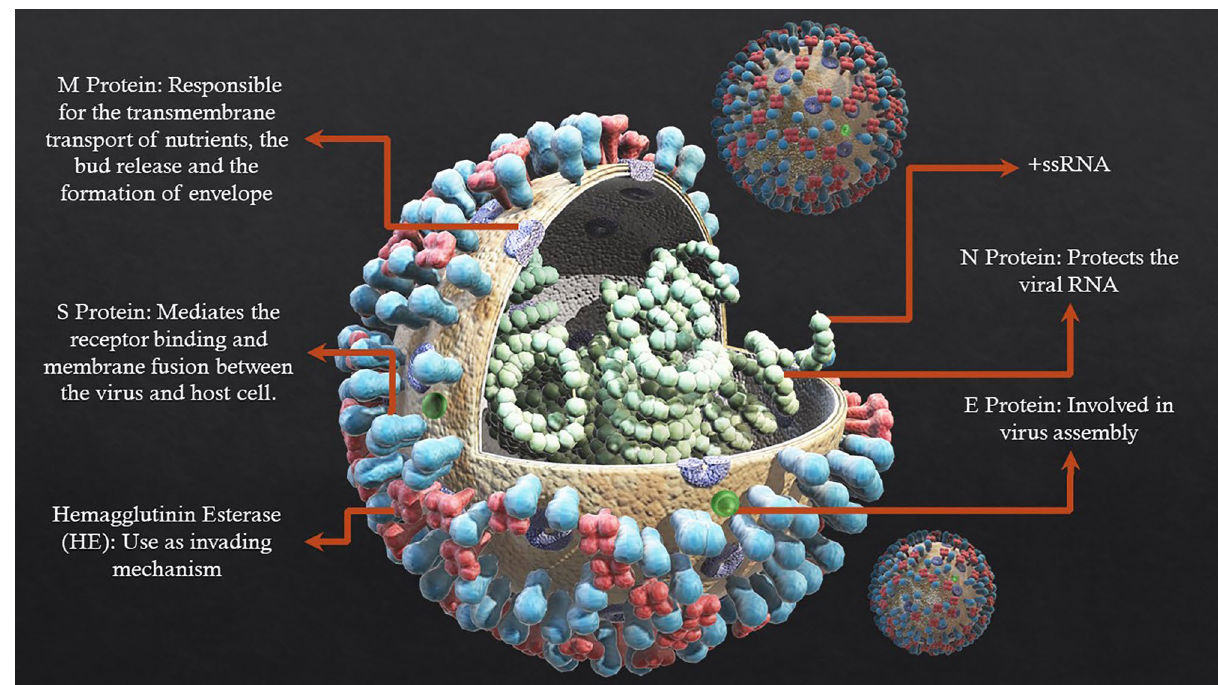
Figure 1. Schematic diagram of the SARS-CoV-2 structure and its several accessory proteins.